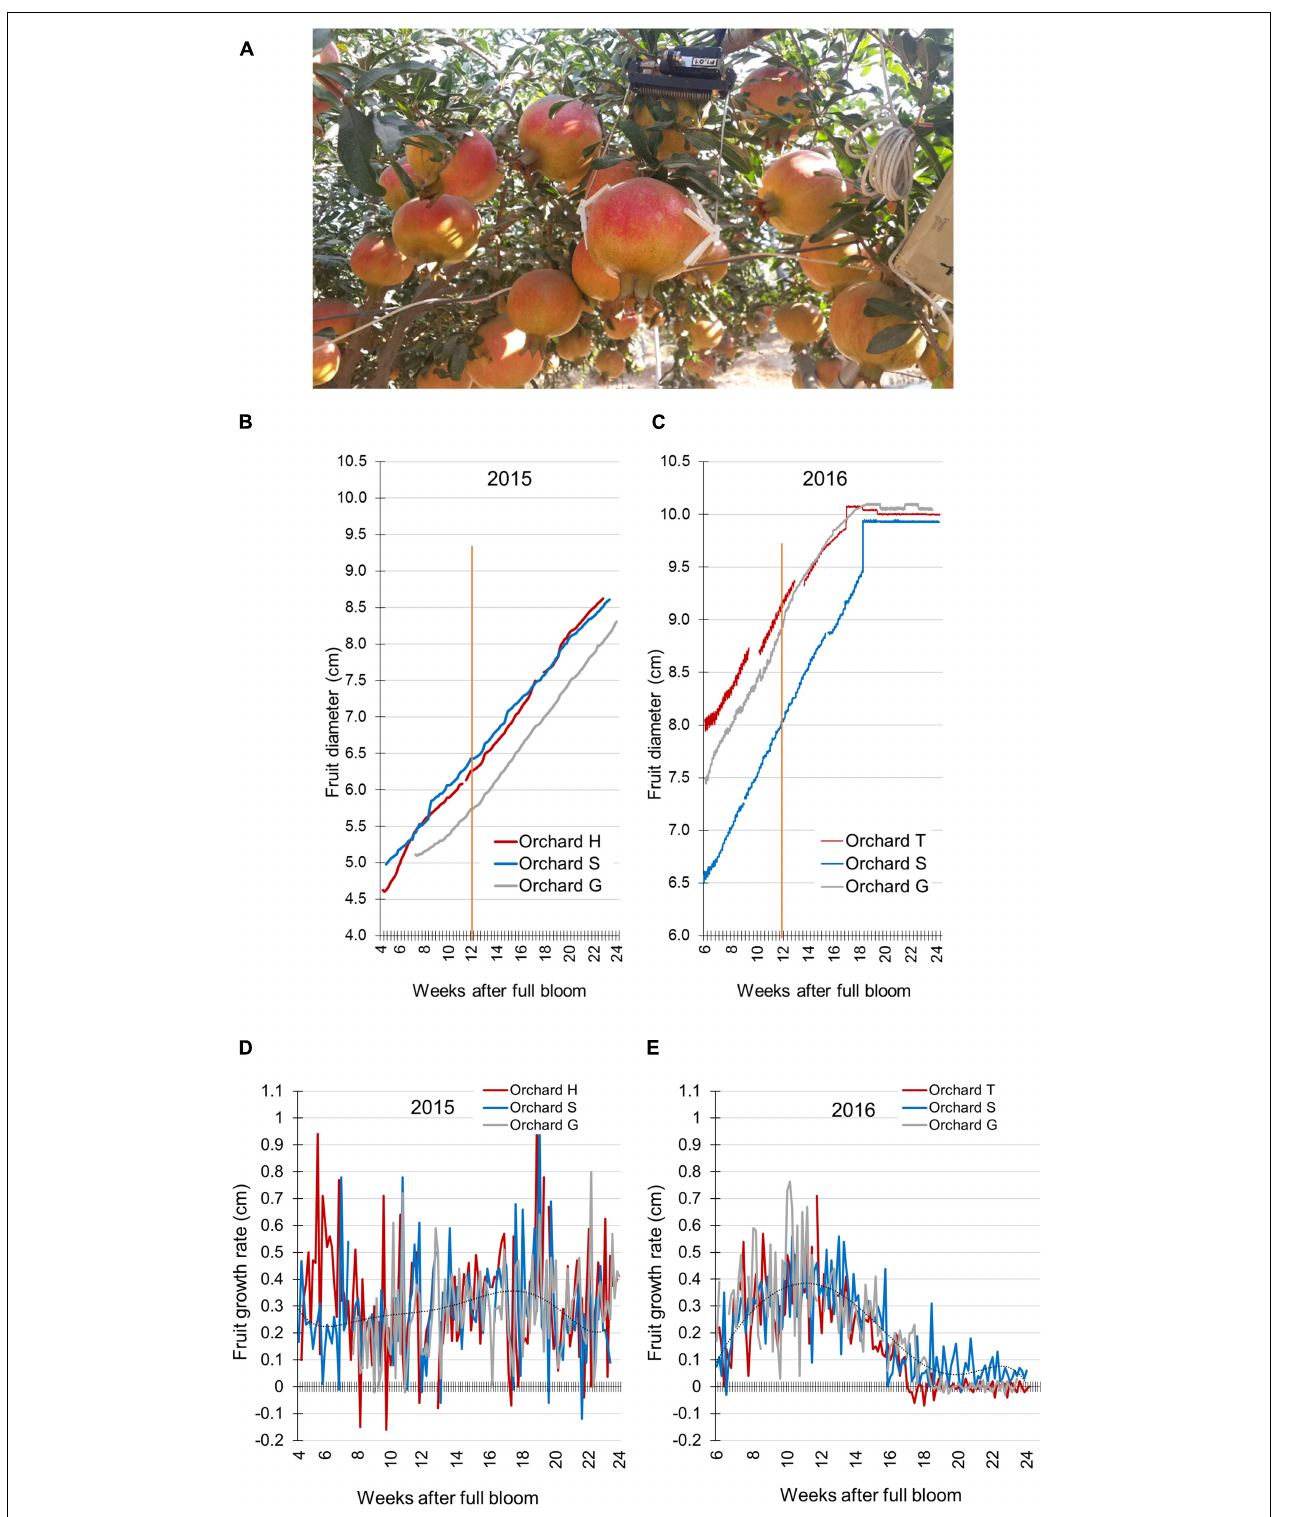
FIGURE 2 | Pomegranate fruit size and growth rate monitored by the Phytech system. (A) Illustration of Phytech sensor and clamps. (B,C) Fruit diameter measured in orchards H, S, and G during 2015 (B) and in orchards T, S, and G during 2016 (C) . Orange line indicates mid-growth (12 weeks after full bloom). (D,E) Daily growth rate was calculated based on the data presented in (B,C) , respectively. A trend line was added on each chart to illustrate growth-rate pattern.